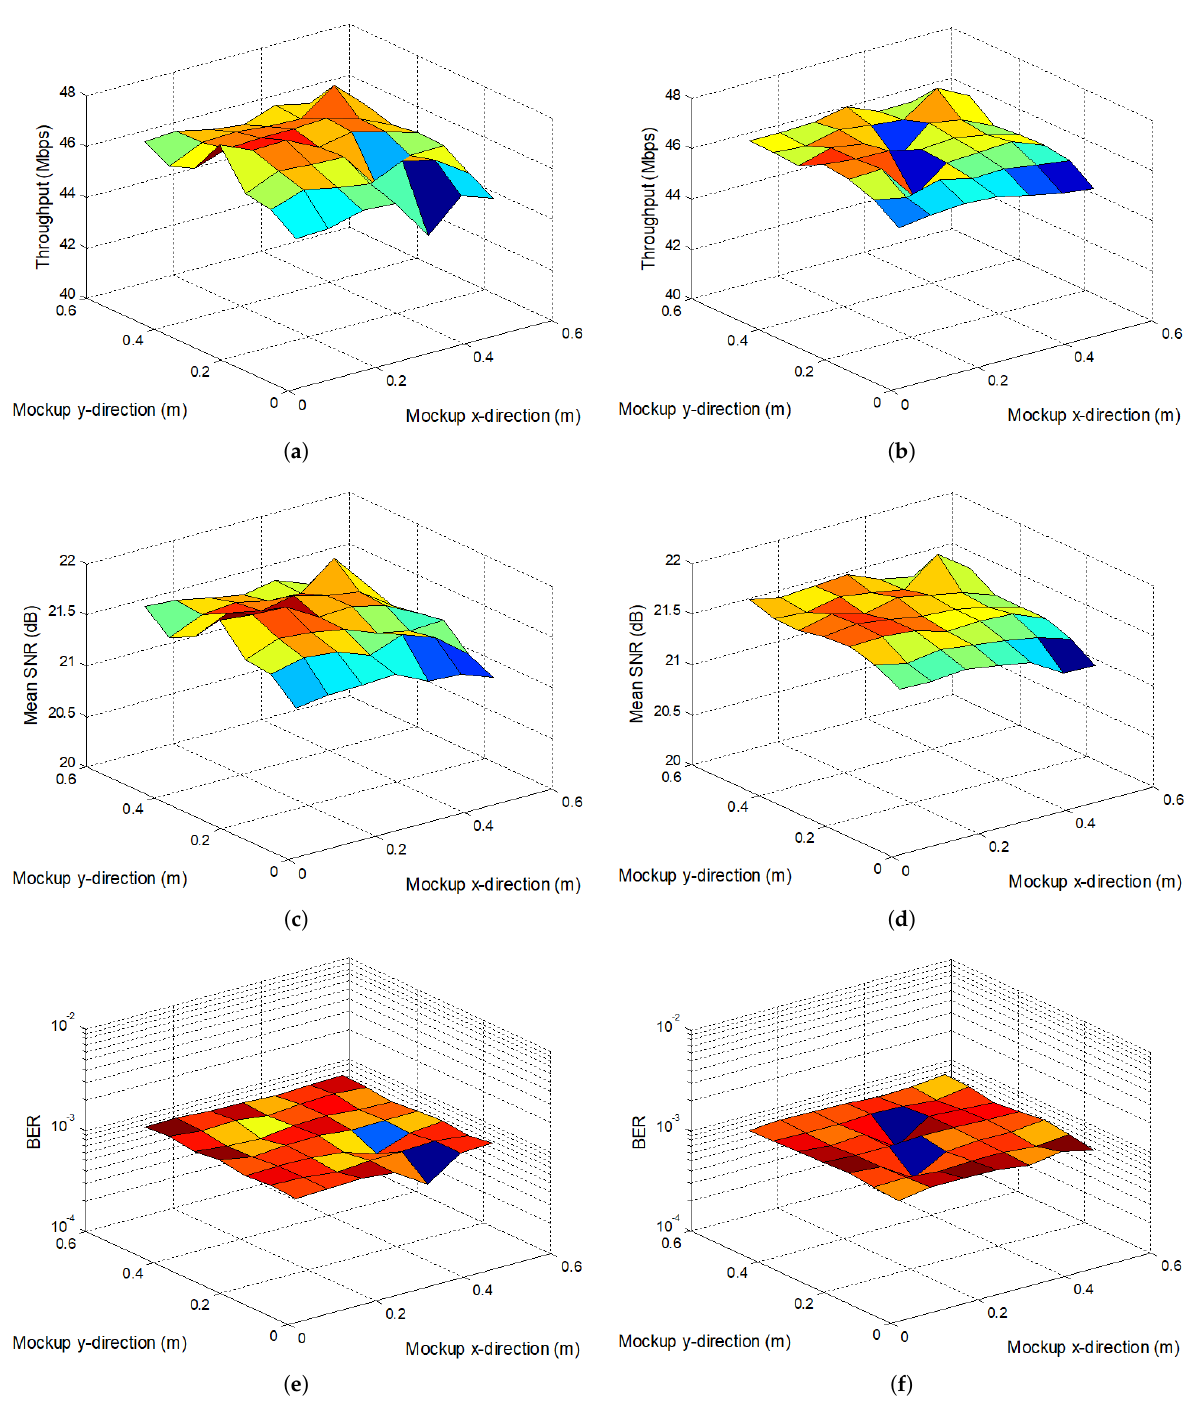
Figure 16. Experimental results for mockup with walls when the four lamps transmit the same data considering vertical orientation upward of the receiver and orientation given by Equation (14): ( a ) Measured throughput for vertical orientation ( R max = 47.5 Mbps, R mean = 46.1 Mbps, R min = 43.9 Mbps). ( b ) Measured throughput for receiver orientation given by Equation (14) ( R max = 47.2 Mbps, R mean = 46.3 Mbps, R min = 45.2 Mbps). ( c ) Measured mean SNR for vertical orientation (SNR max = 21.8 dB, SNR mean = 21.5 dB, SNR min = 21.1 dB). ( d ) Measured mean SNR for receiver orientation given by Equation (14) (SNR max = 21.8 dB, SNR mean = 21.5 dB, SNR min = 21.2 dB). ( e ) Measured BER for vertical orientation (BER max = 1.2 × 10 − 3 , BER mean = 1.1 × 10 − 3 , BER min = 0.7 × 10 − 3 ). ( f ) BER for receiver orientation given by Equation (14) (BER max = 1.2 × 10 − 3 , BER mean = 1.1 × 10 − 3 , BER min = 0.7 × 10 − 3